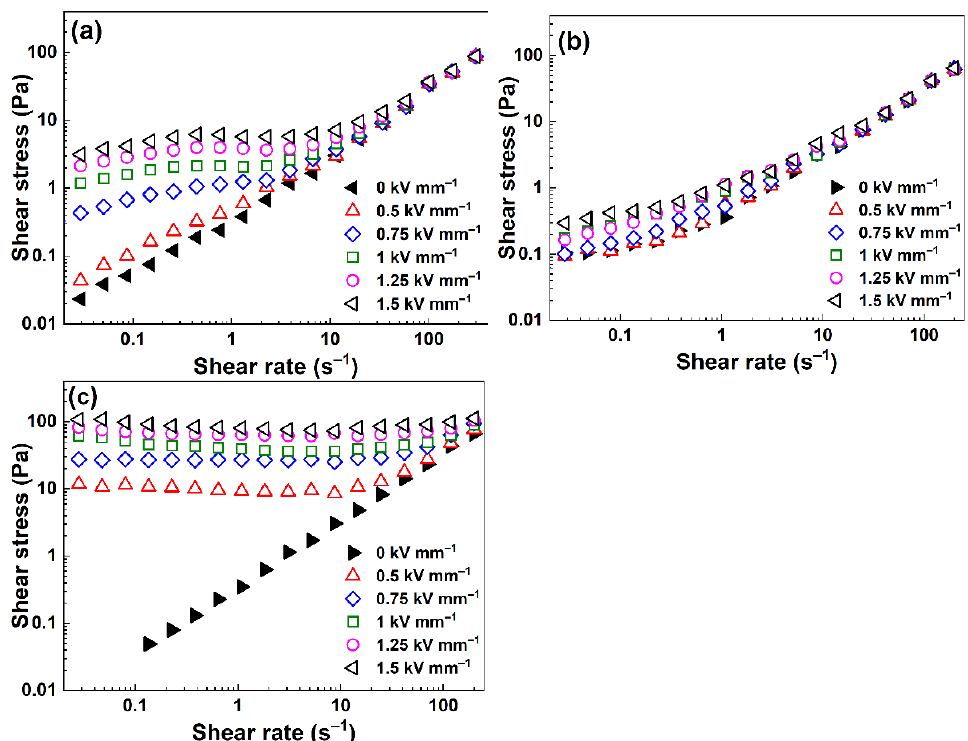
Figure 6. Log–log dependence of shear stress on the shear rate for prepared ER fluids based on ( a ) cellulose, ( b ) HTC-Cellulose and ( c ) HTC-TC600-Cellulose. The concentration of the particles was 5 wt%.